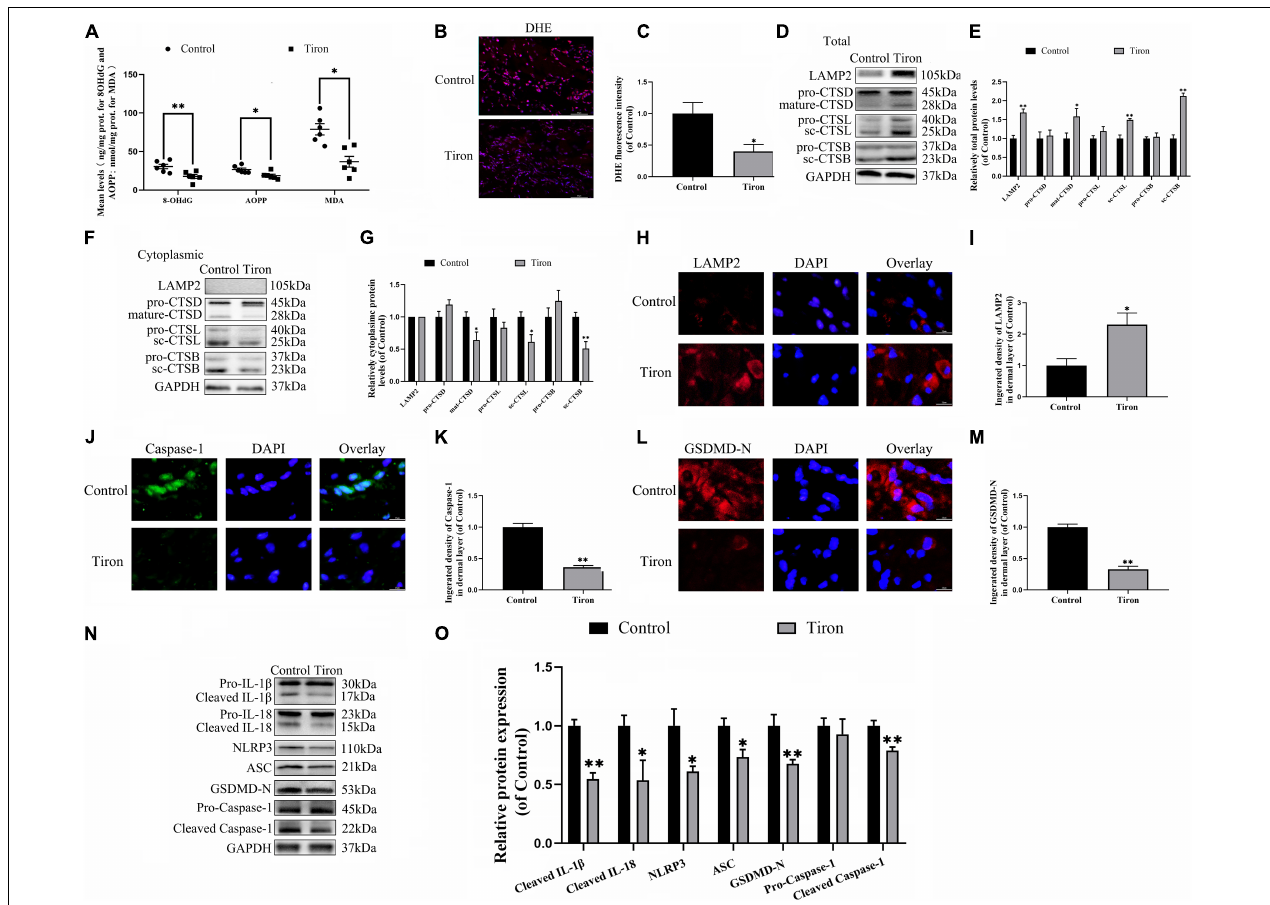
FIGURE 4 | ROS-induced lysosomal malfunction leads to initiation in flaps. (A) ELISA of MDA, 8-OHdG, and AOPP and in flap tissue from the control and Trion groups. (B,C) DHE staining for sections was conducted to determine the ROS levels (scale bar: 50 mm). (D,F) Western blotting of the lysosome function-related proteins CTSD, LAMP2, CTSB, and CTSL in total protein and cytoplasmic protein from the control and Trion groups. (E,G) Quantification of CTSD, LAMP2, CTSB, and CTSL immunoblots. (H) Immunofluorescence for LAMP2 in flaps (scale bar: 25 mm). (I) The fluorescence intensity of immunofluorescence staining of LAMP2. (J) Immunofluorescence to evaluate the caspase-1 level (scale bar: 25 mm). (K) The fluorescence intensity of caspase-1. (L) Image of the immunofluorescence staining of GSDMD-N in skin flaps (scale bar: 25 mm). (M) The fluorescence intensity of GSDMD-N analyzed using ImageJ. (N) Western blotting of pyroptosis related proteins in the control and Trion groups. (O) Quantification of pyroptosis related proteins immunoblots. Values represent the mean ± SEM, n = 6 per group. * p < 0.05 and ** p < 0.01, vs. control